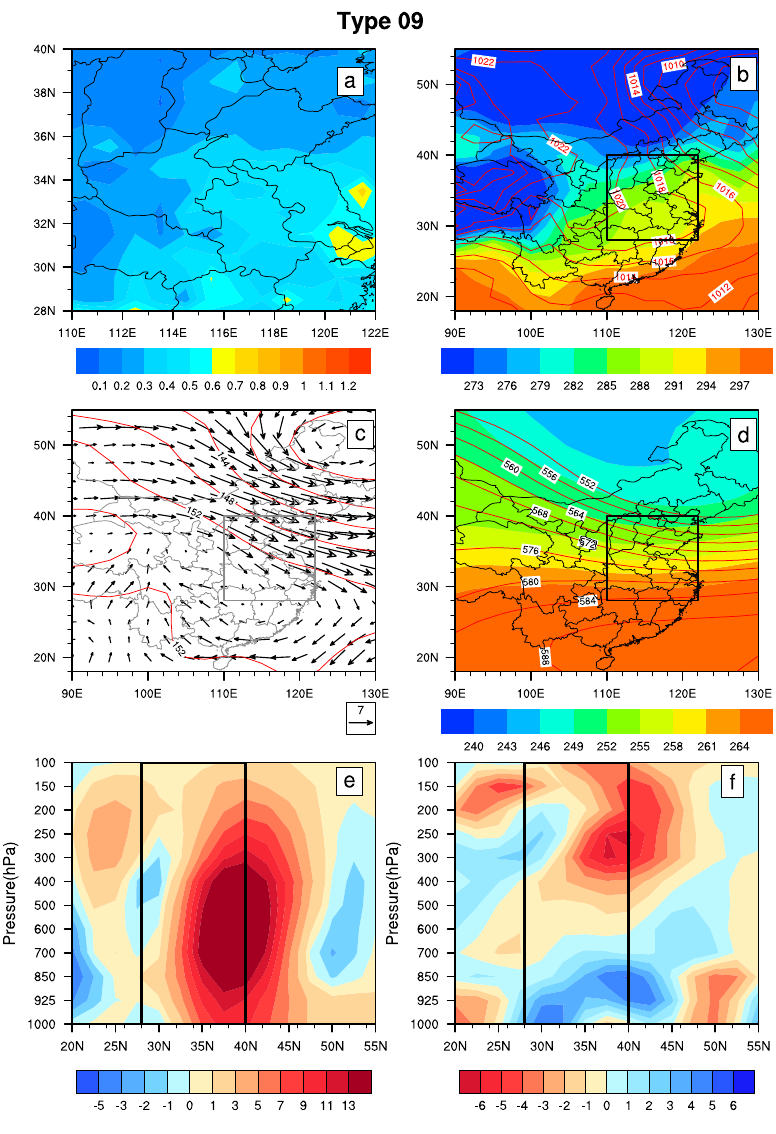
Figure 16. As in Fig. 8 but for Type 9